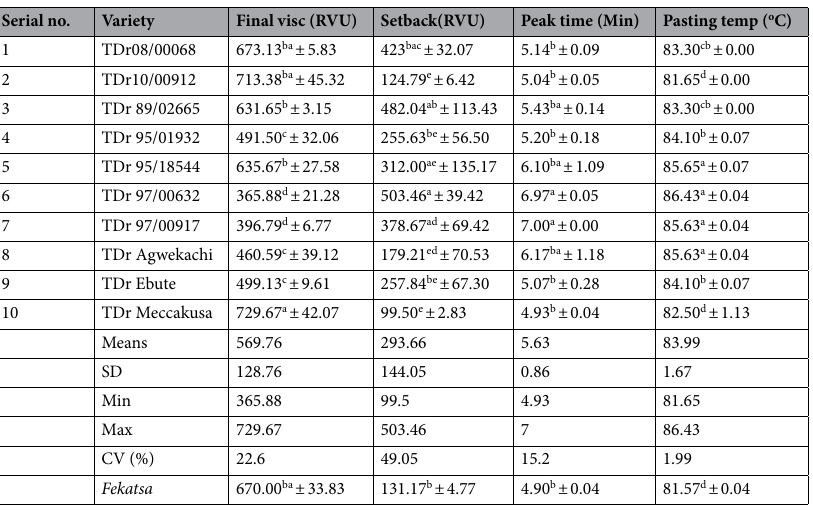
Table 3. Yam varietal effects on other pasting attributes (pasting temperature, final viscosity and setback viscosity) of the instant pounded fufu samples as obtained from control( Fekatsa ) and 10 improved varieties of Dioscorea rotundata. Parameter mean value ± SD; Values with the same superscripts in the same column are not significantly different ( p > 0.05); Visc = Viscosity; temp = temperature; RVU = Rapid Visco Analyser